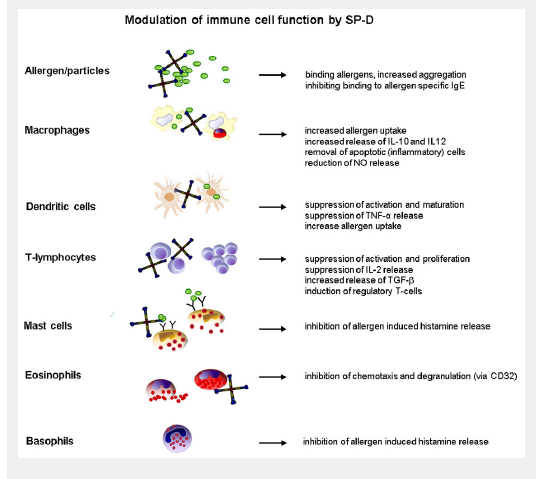
Overview of interactions between surfactant protein-D and immune effector cells, which orchestrate the pulmonary immune response during the onset of allergic airway